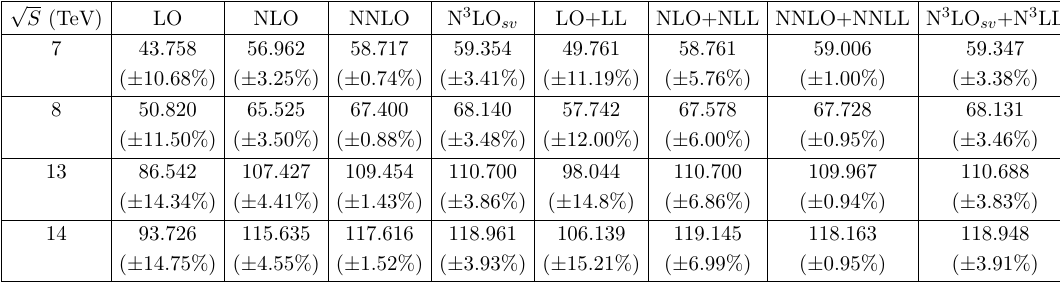
Table 2 . Same as table 1 but for W + production at the LHC.